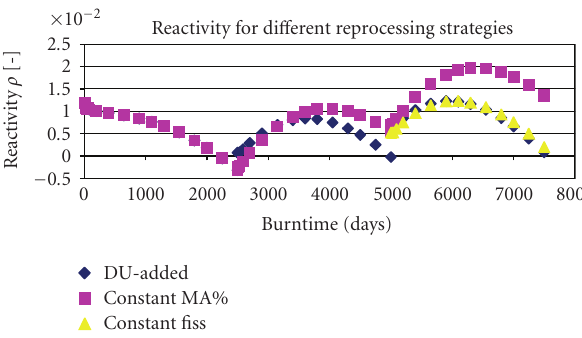
Figure 6: For 3 subsequent fuel irradiations in a closed fuel cycle, the k e ff as a function of time. The “Constant fiss.” curve corresponds to the constant reactivity weight refueling strategy.